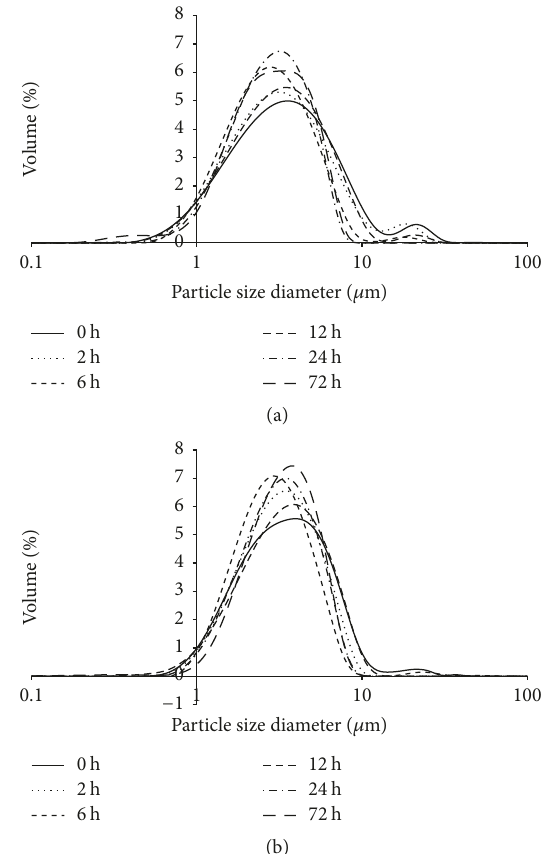
Figure2:Particlesizedistributionsof(a)crudeoilbody(COBs)and (b) washed oil body (WOBs) emulsions at different seed presoaking